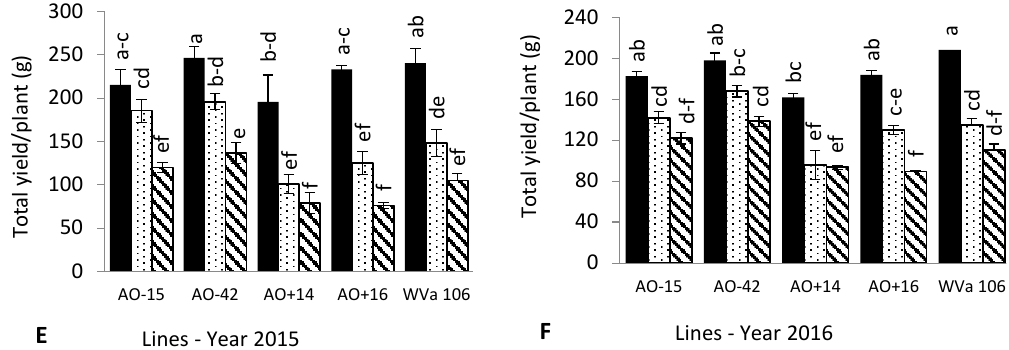
Figure 3. The effect of three salinity levels 0 mM (black bars), 75 mM (speckled bars), and 150 mM NaCl (striped bars) on cherry tomato lines. ( A ) Cluster number in 2015, ( B ) cluster number in 2016, ( C ) flower numbers/ cluster in 2015, ( D ) flower number/cluster in 2016, ( E ) total yield/plant in 2015, and ( F ) total yield/plant in 2016. Results with the same superscript were not significantly different ( p < 0.05) according to the classification obtained by the Duncan test.